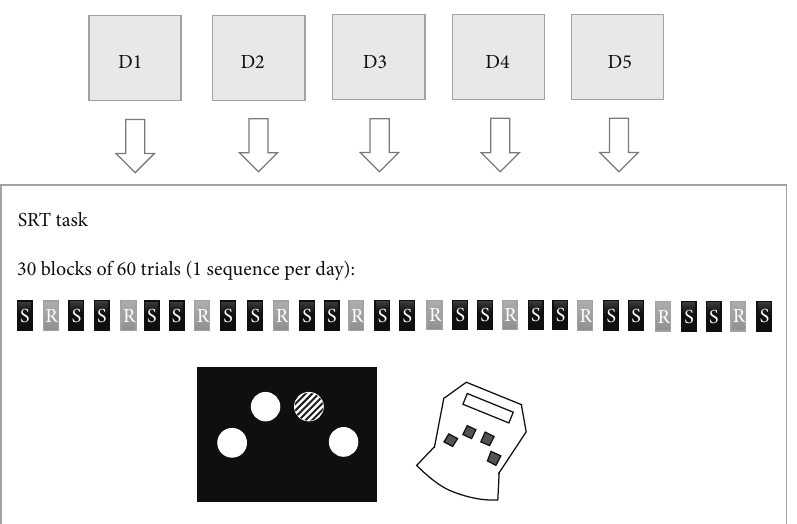
Figure 1: Study design and SRT task paradigm, stimuli, and keyboards. The five grey squares, D1 to D5, refer the five days of training. Grey rectangles containing the letter “R” refer to random blocks and the black rectangles containing the letter “S” refer to sequence blocks. The unscaled schematic representation of the stimuli displayed on the computer screen and the keyboard used to perform the SRT task are depicted. The yellow circle used as the GO signal is displayed here as a striped circle.